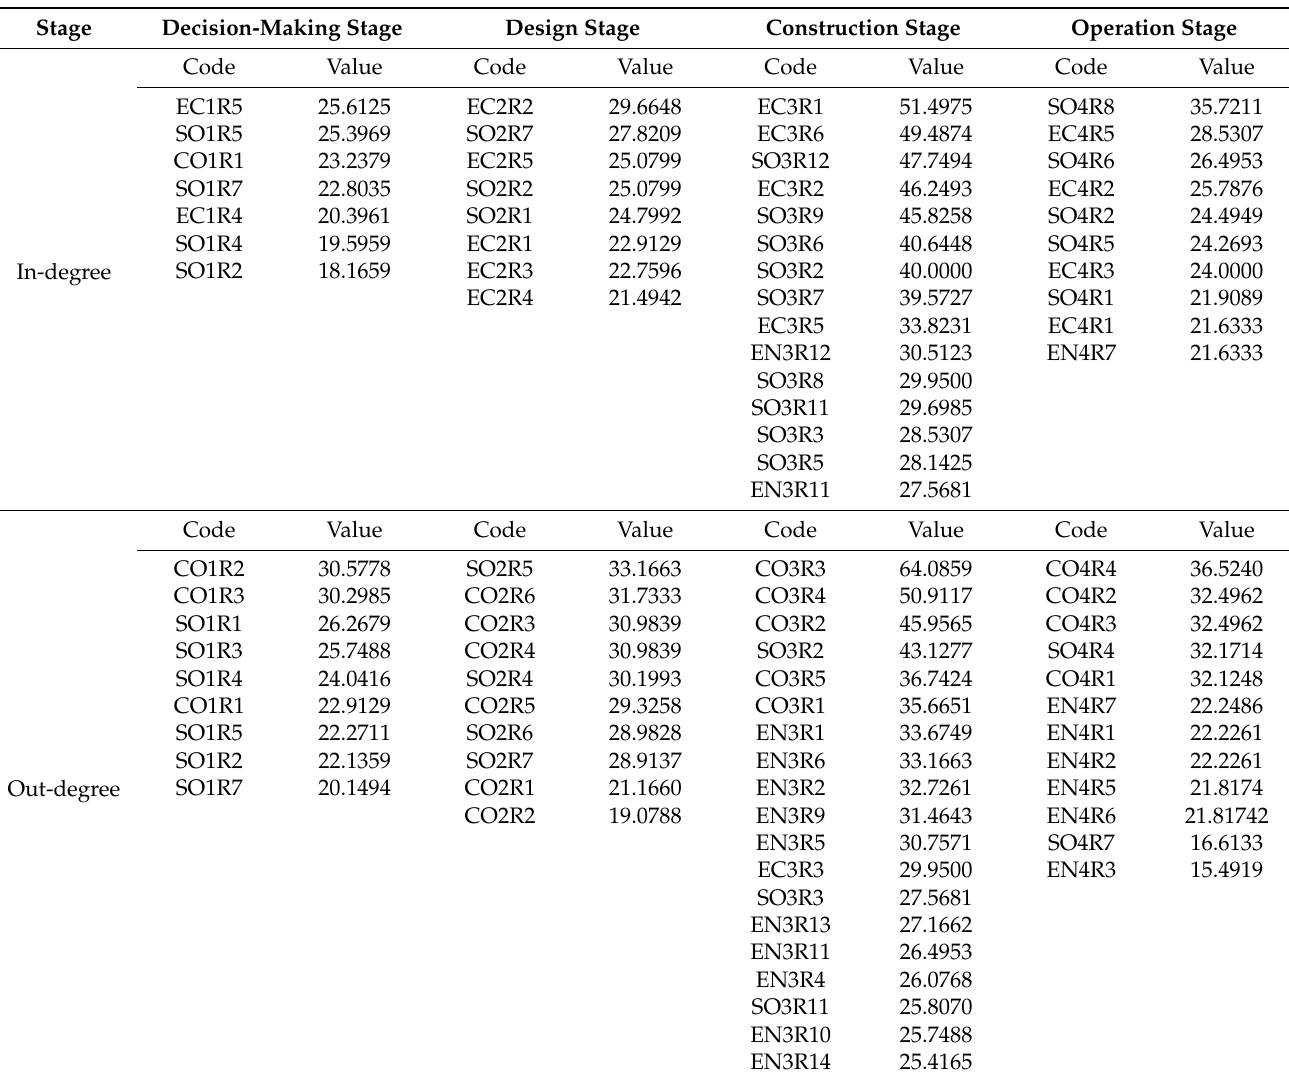
Table 4. In-degree key risks and out-degree key